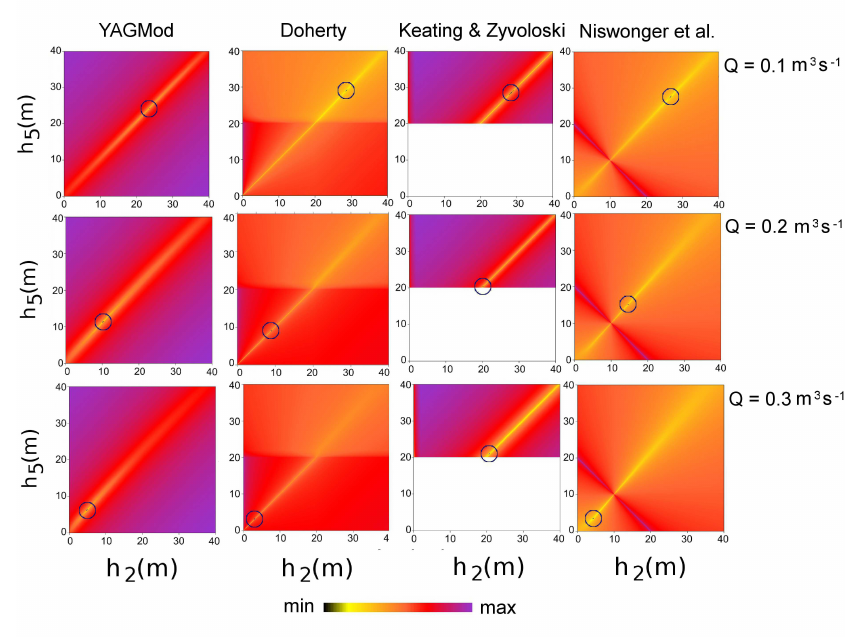
Figure 6. Map of the total quadratic balance errorgiven by Equation (17), as a function of the hydraulic heads h ( 2 ) ( x axis) and h ( 5 ) ( y axis). From left to right, respectively, the results obtained with YAGMod and the approaches by Doherty [3], Keating and Zyvoloski [4] and Niswonger et al. [6]. From top down, the results obtained with extraction rates of 0.1 m 3 s − 1 , 0.2 m 3 s − 1 and 0.3 m 3 s − 1 . The blue circles point out the zone where the least value of the total quadratic balance error is